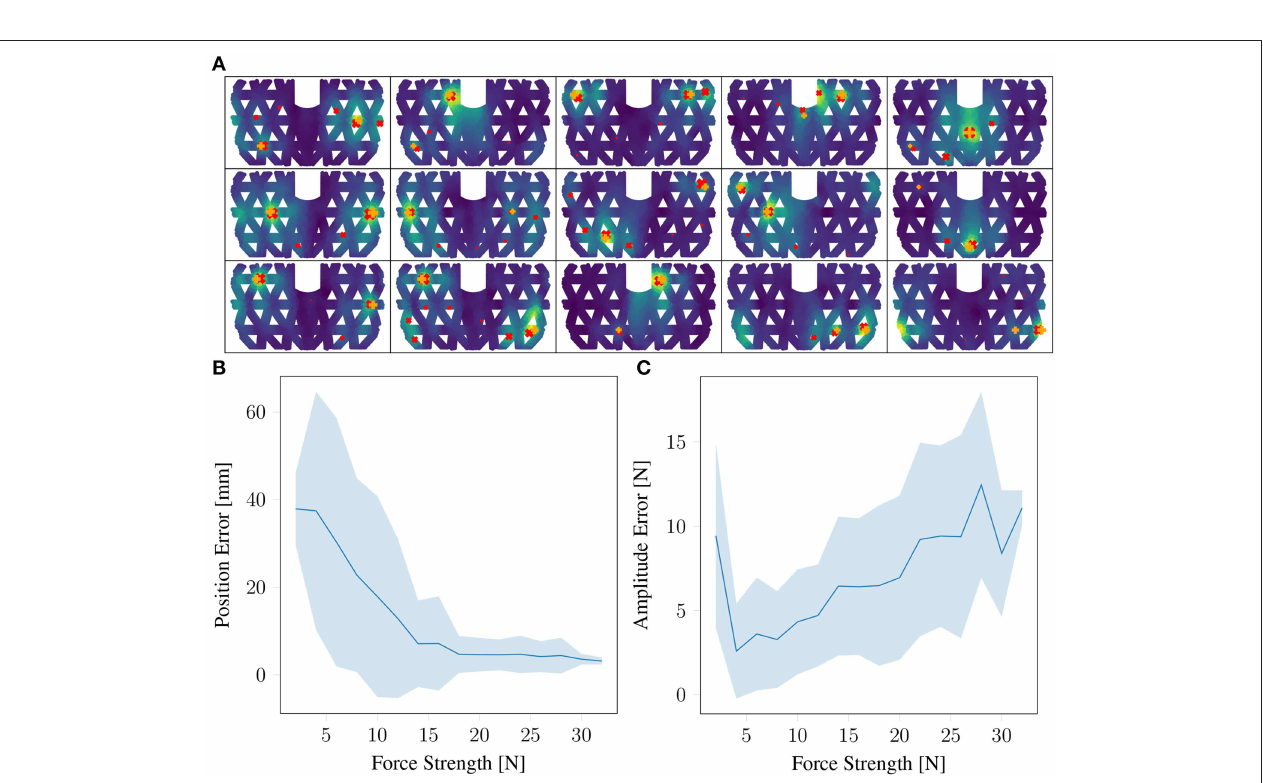
FIGURE 9 | Results on double-contact of the entire framework: (A) are predicted deformation patterns and detected contact points (orange + : true points, red × : detected) for double-contact. The size of the crosses reflect the force strength. (B) is the prediction error for position of double contact based depending on the force strength. (C) is the same for force magnitude. One contact points is fixed at around